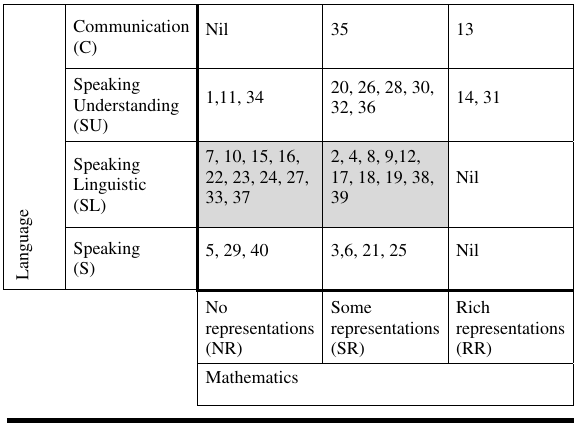
Plot mapping oral language use and degree of mathematical repre- sentation across all schools (n = 40).